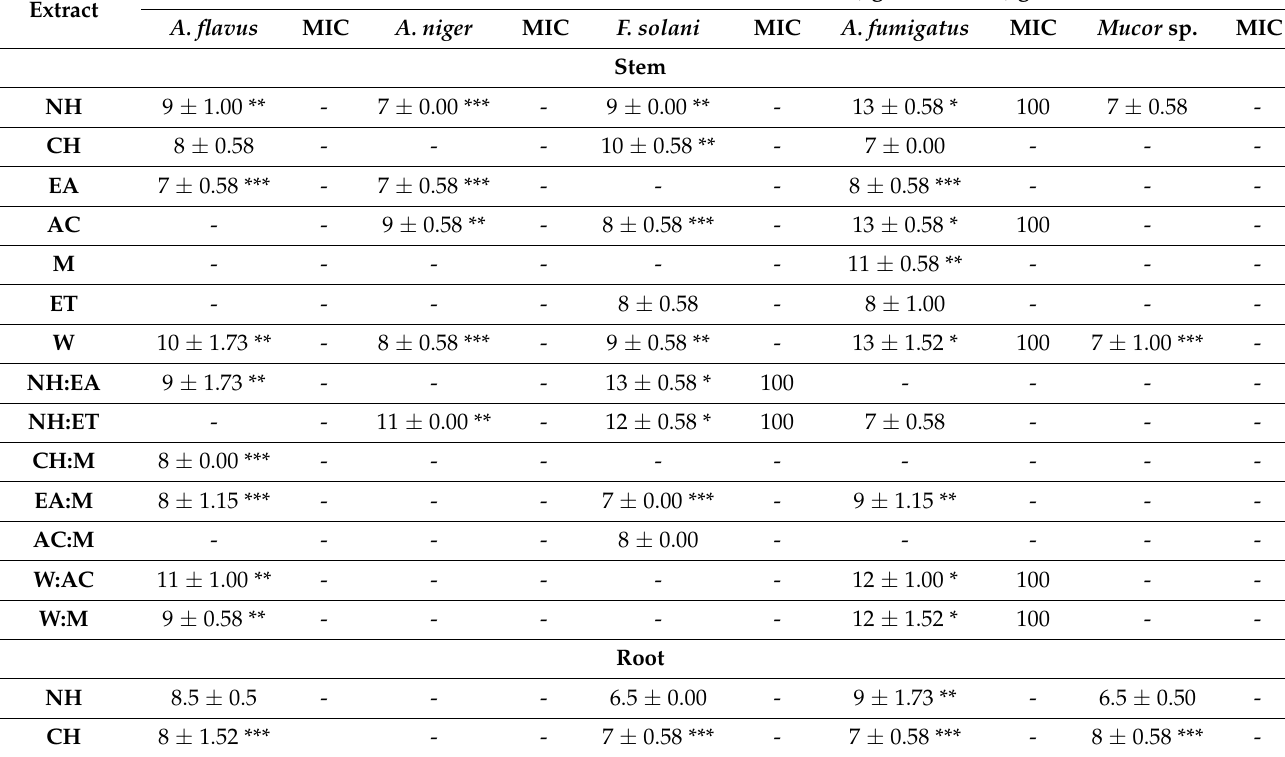
Table 4. Results of antifungal activity of different solvent extracts of stem, root, seeds, and leaves of P. glabrum